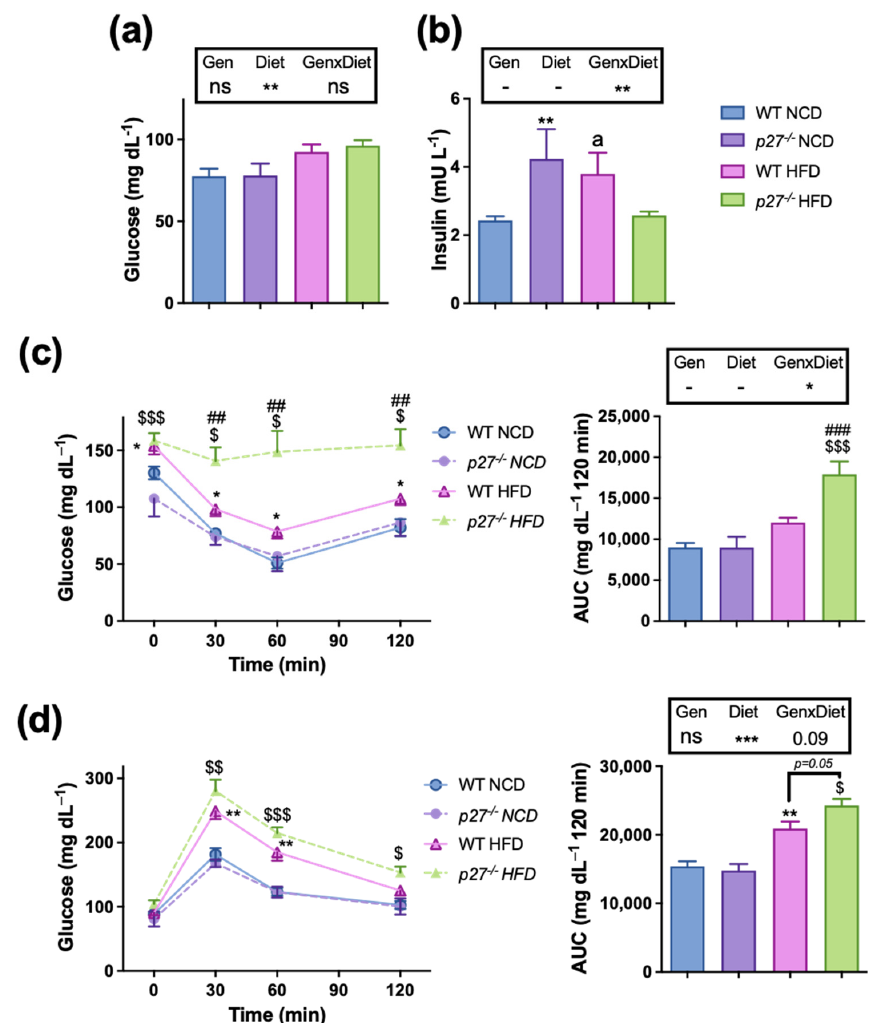
Figure 3. p27 − / − mice on HFD exhibit severe insulin resistance. ( a , b ) Fasting serum glucose ( a ) and insulin ( b ) in WT and p27 − / − mice fed with NCD or HFD for 10 weeks. ( c ) An insulin tolerance test (ITT) was performed after 6 h of fasting, and then mice were injected i.p. with 0.375 mU/g of body weight of rapid insulin and blood glucose levels were measured before and 30, 60 and 120 min after injection. ( d ) A glucose tolerance test performed after overnight fasting, and then mice were injected i.p. with 1 g/kg of body weight of glucose and blood glucose levels were measured before and 30, 60 and 120 min after injection. Data are expressed as mean ± SEM ( n = 5–27). The legend